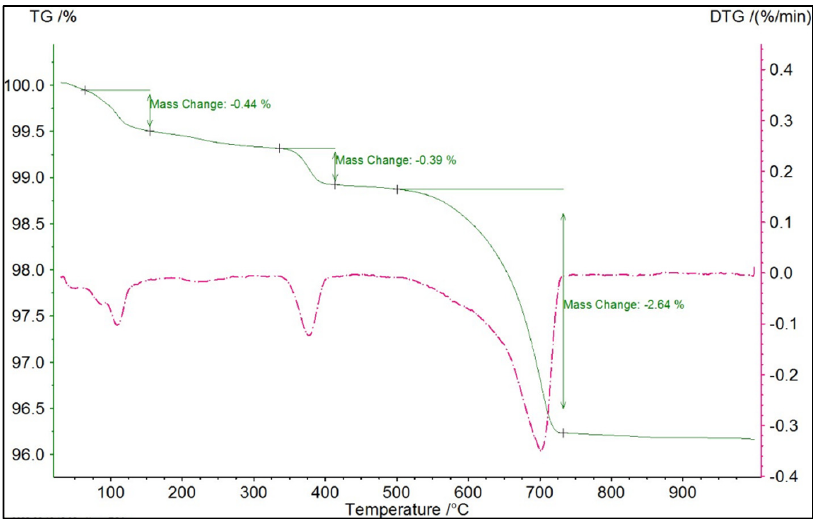
Figure 3. TGA and DTG of the unhydrated clinker. Table 2. Proportion of Portlandite and Calcite over time from TGA (Molar mass of Portlandite, Wa-